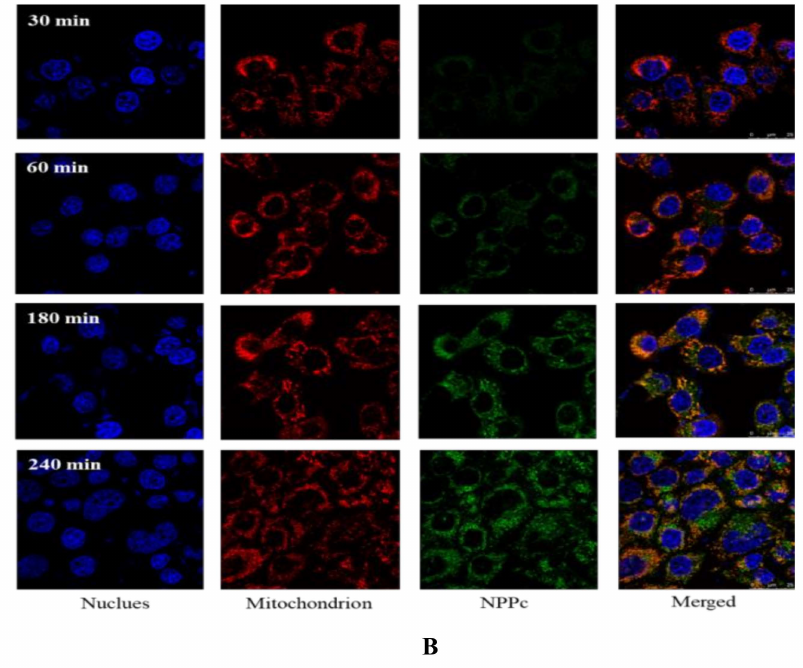
Figure 7. Localization of NPPc (1500 µ g/mL) in endoplasmic reticulum ( A ) and mitochondrion ( B